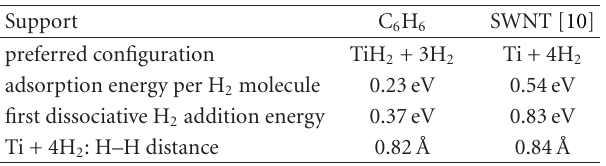
Table 4: Comparison of SWNT and C 6 H 6 supports for H 2 adsorp- tion on